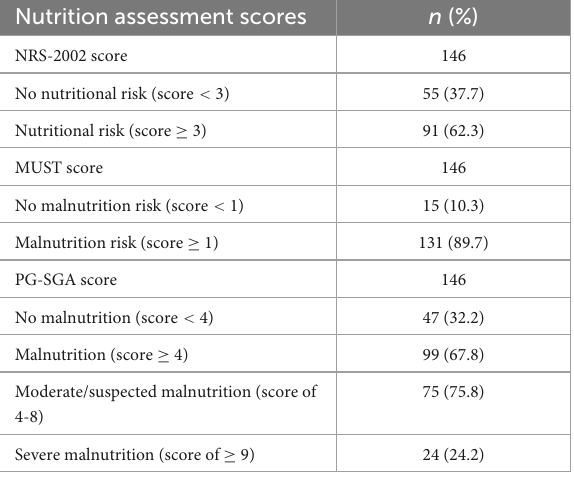
TABLE 2 The scores of the different nutrition assessment tools ( n =